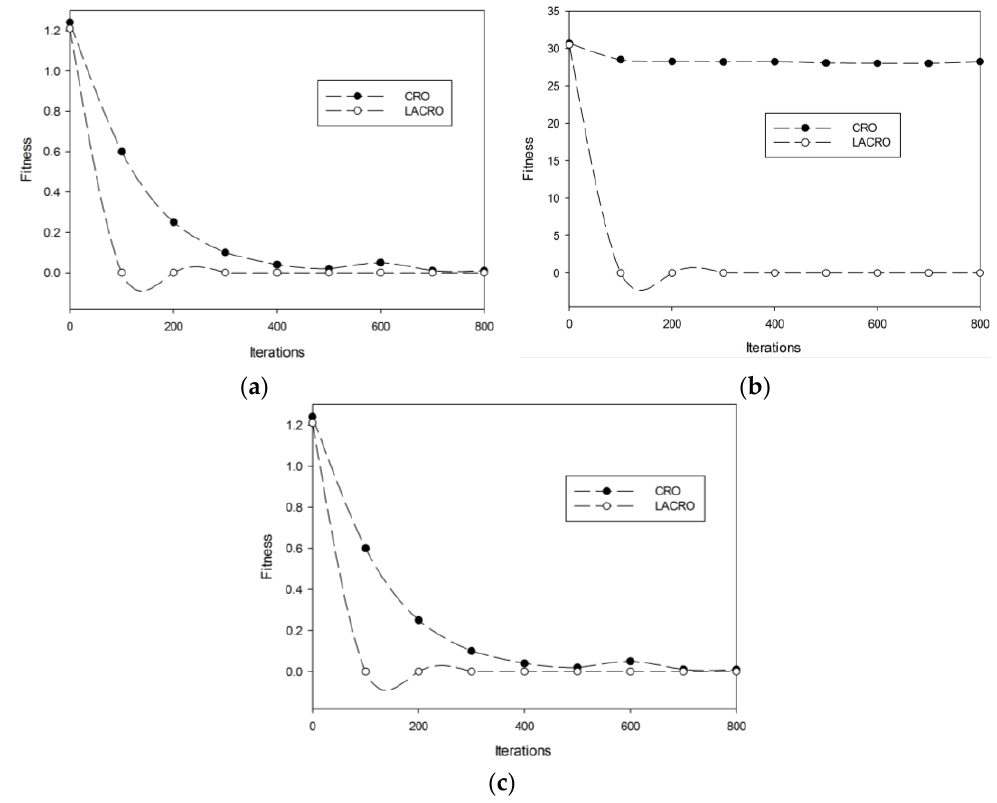
Figure 2. Comparison of LACRO and CRO. ( a ) f 1 Rastrigrin; ( b ) f 2 Rosenbrock; ( c ) f 3